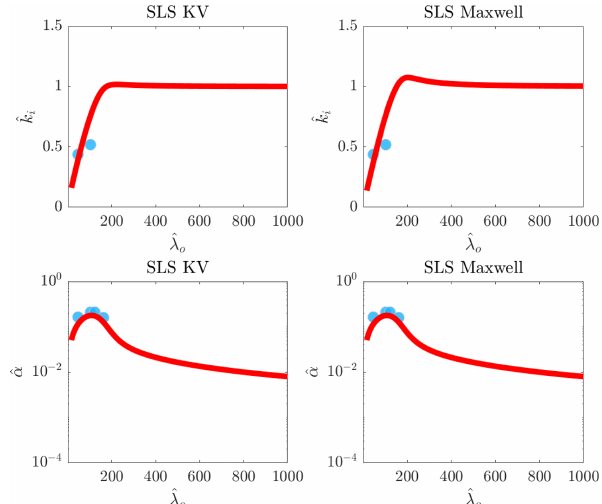
Figure 13. Comparison between predictions of SLS models and val- ues measured by Yiew et al. (2019). Upper and lower rows show the decay rates and dispersion plots. The equivalent Young’s modulus of the SLS KV model is 2 . 5 × 10 4 Pa, and the equivalent Young’s modulus of the SLS Maxwell model is 3 . 3 × 10 9 Pa. Dynamic vis- cosity of the SLS KV model is 4 × 10 7 Pas, and dynamic viscosity of the SLS Maxwell model is 3 . 5 × 10 9